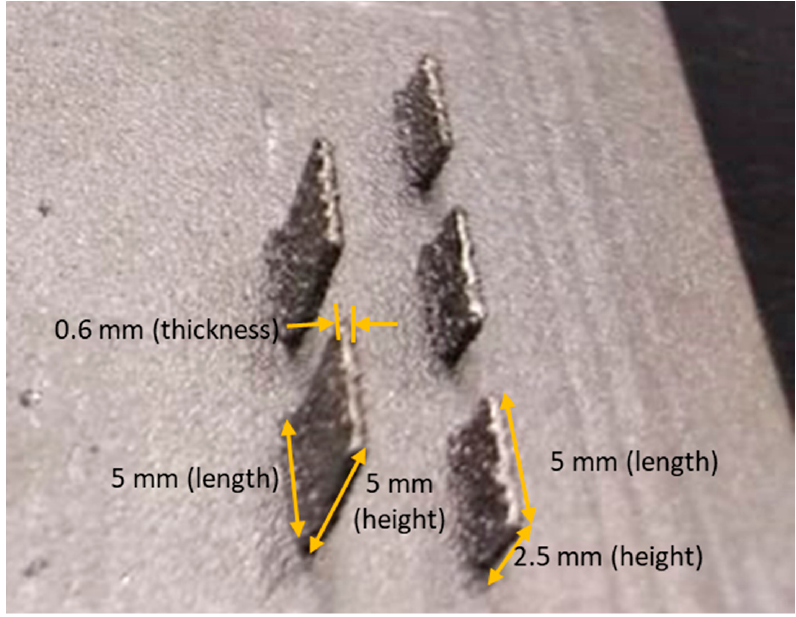
Table 4. Parameters used in the simulations and for producing the EBM parts [29]